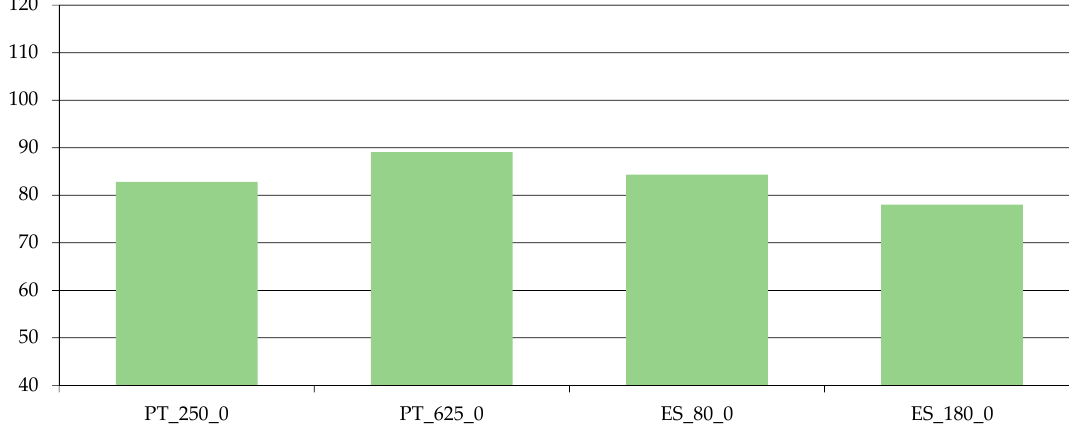
Figure 7. Weaned calves per 100 cows and year (n°). Source: model results.